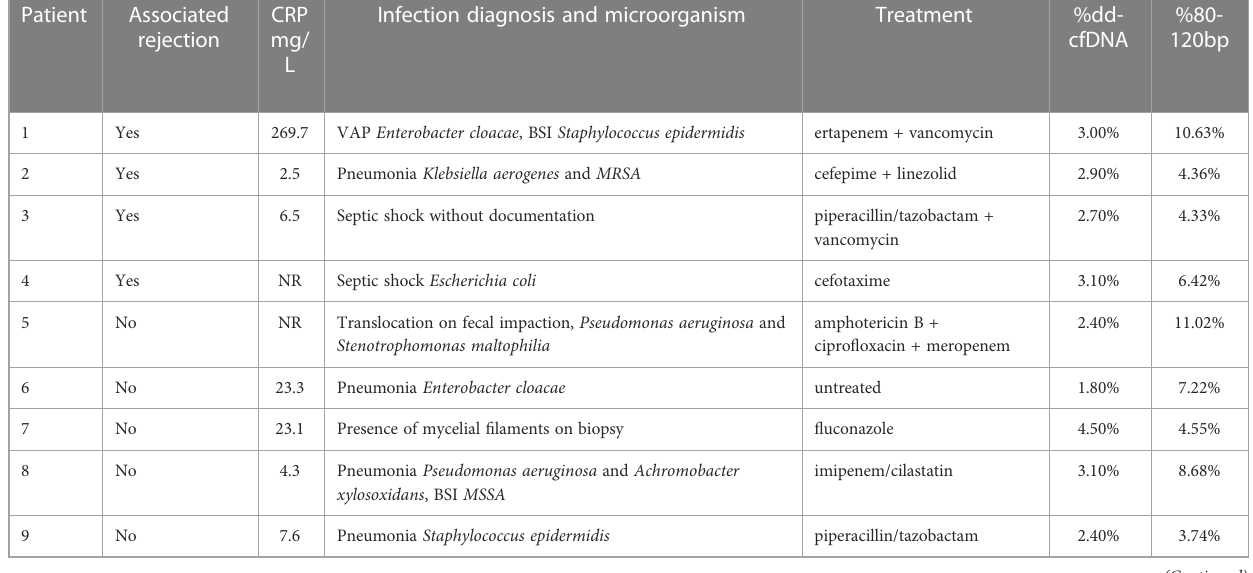
Table 2B Description of injured graft patients at D30: Clinical and biological characteristics of infections. Patient